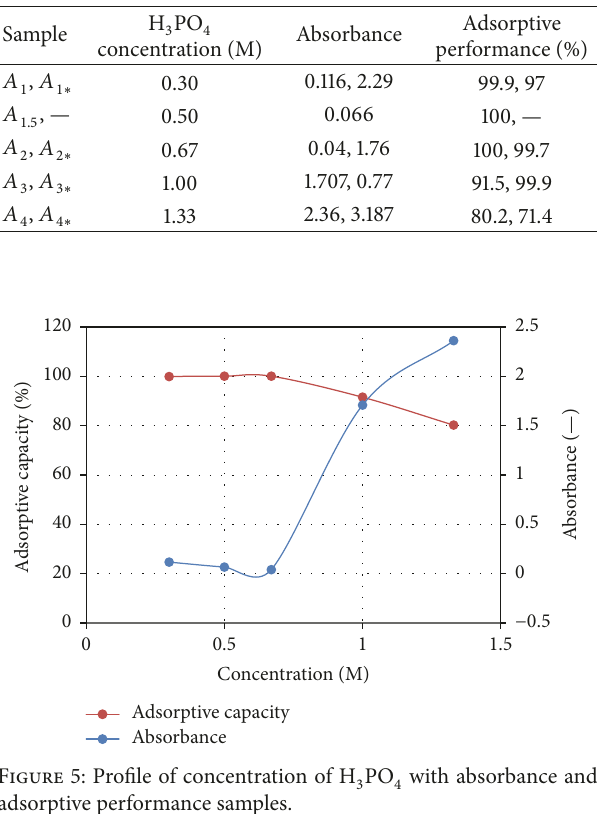
Table 5: Effect of activating agent concentration on absorbance and adsorptive performance.